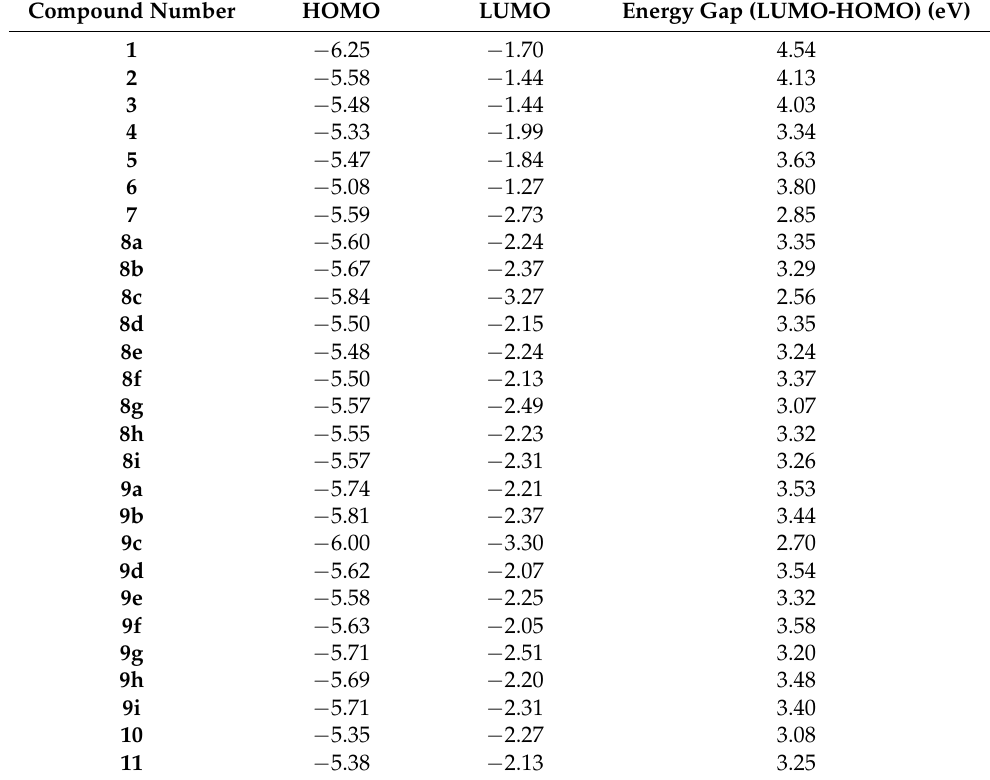
Table 3. HOMO energy. LUMO energy. and LUMO-HOMO energy gap of compounds calculated using DFT(B3LYP)/6-31G+(d). Compound Number HOMO